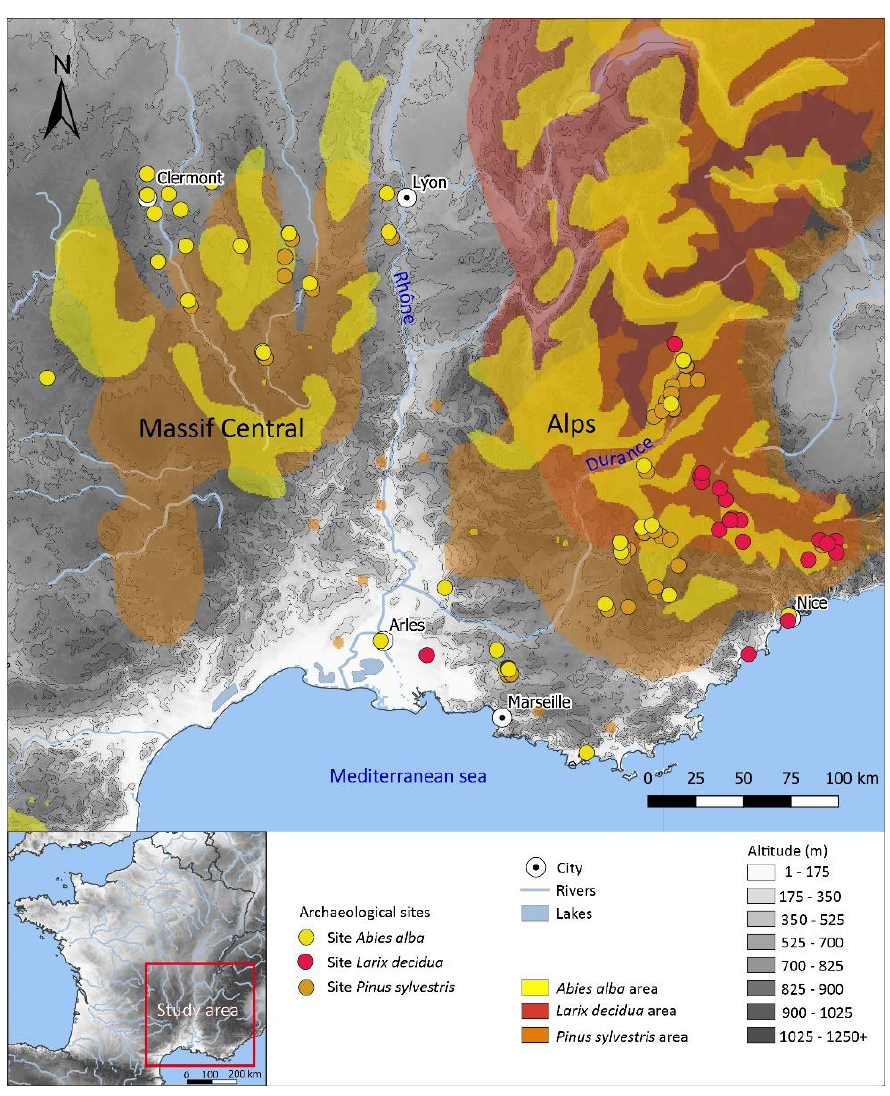
Figure 1. Map of the 279 archaeological sites (circles) represented with their predominant species (fir, larch or Scots pine). In the background, the current cover of forest stands.